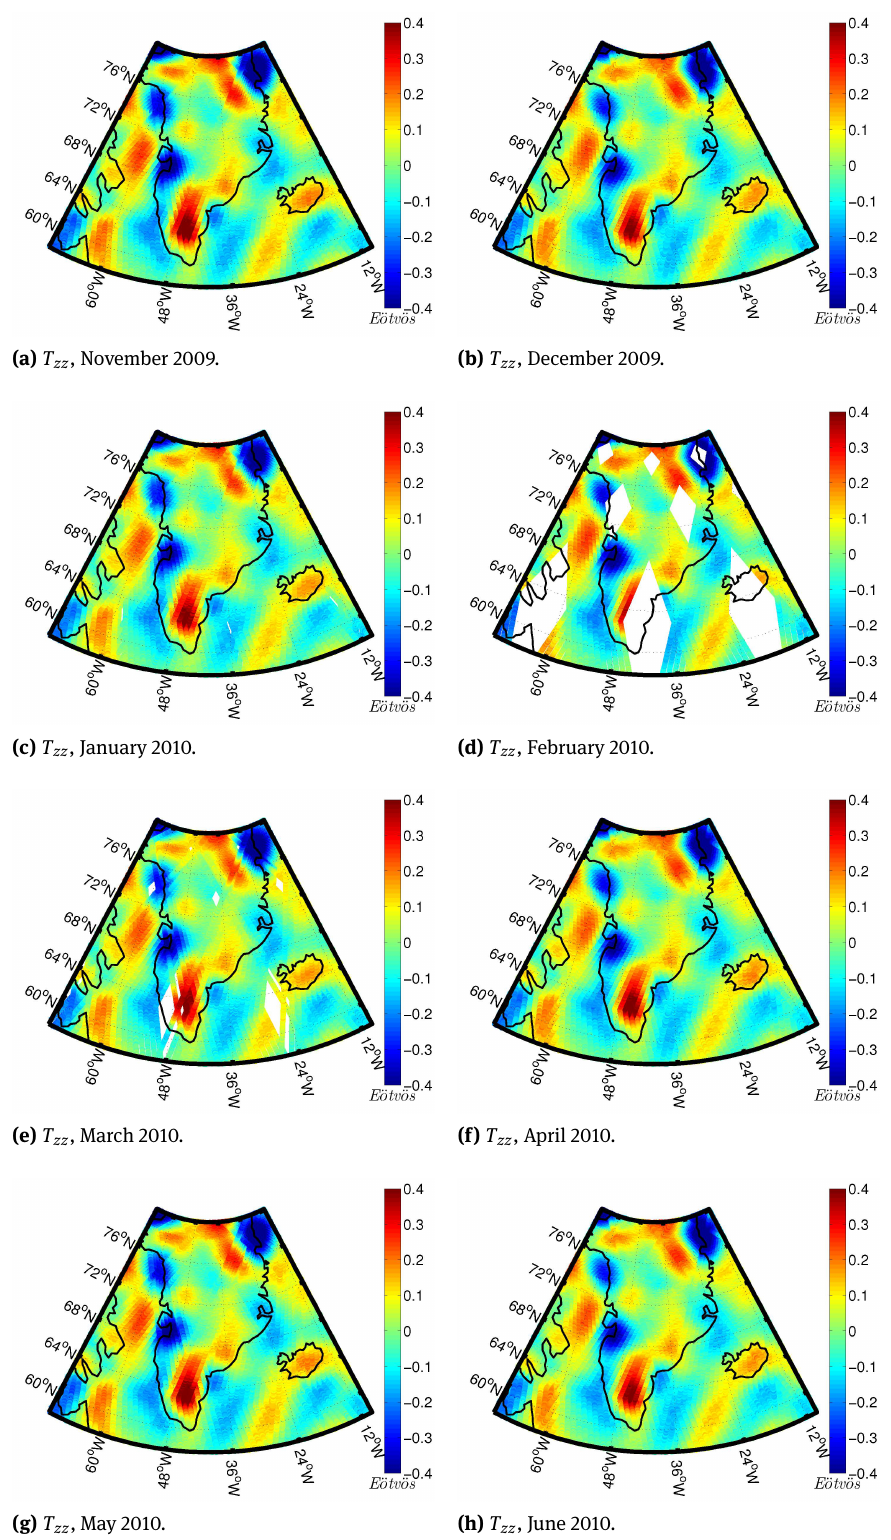
Fig. 2. Monthly solutions for GOCE T zz gradients when the contribution from the global model EGM2008 up to spherical harmonic degree and order 36 is subtracted. The given units are E ¨ o tv ¨ o s